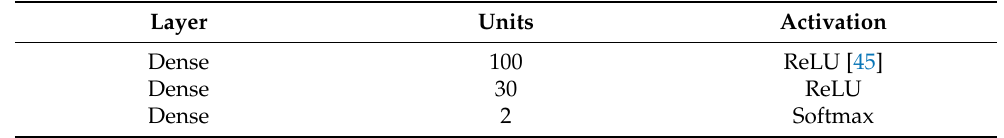
Table 2. Model architecture for the ozone and the adult datasets (dense